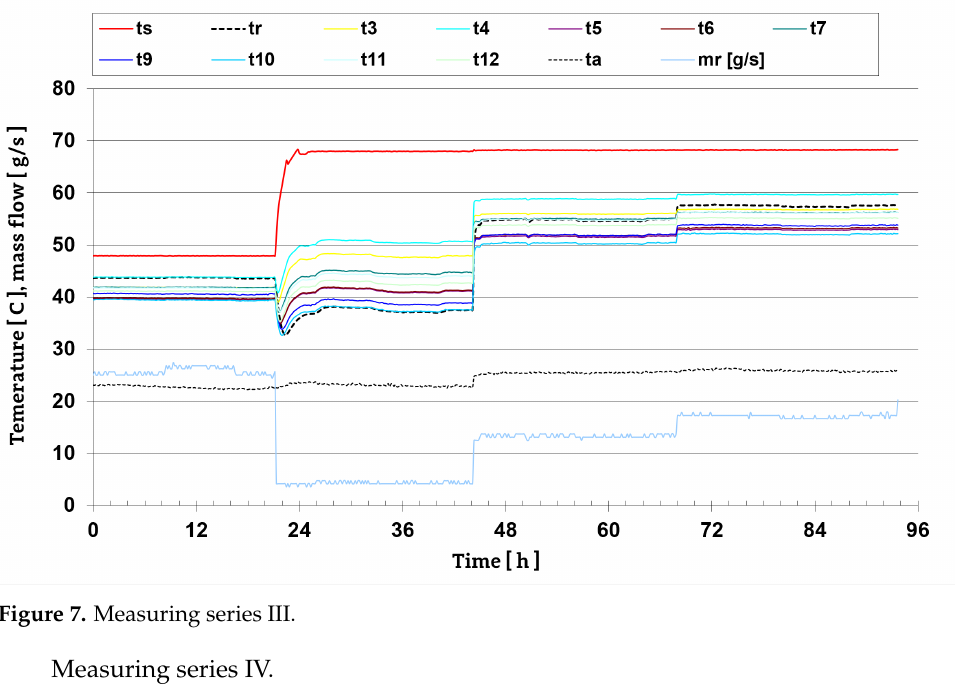
Figure 7. Measuring series III. Measuring series IV.